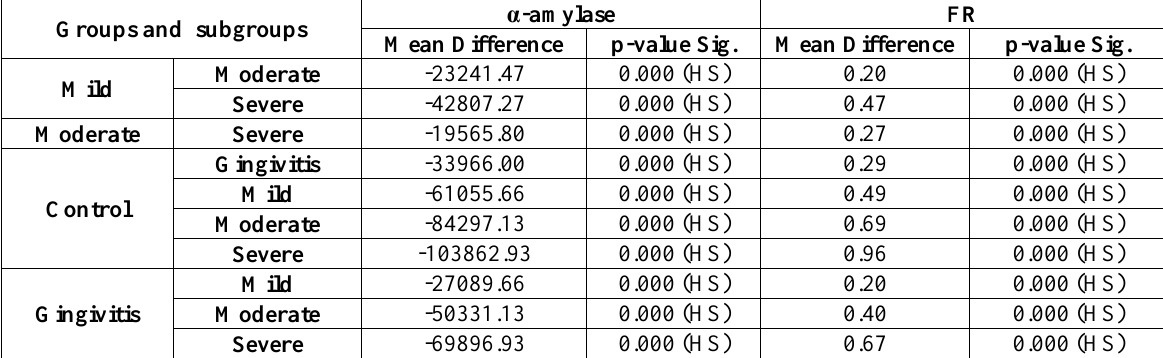
Table 4: Mean differences of salivary α-Amylase and FR between all pairs of groups and subgroups.